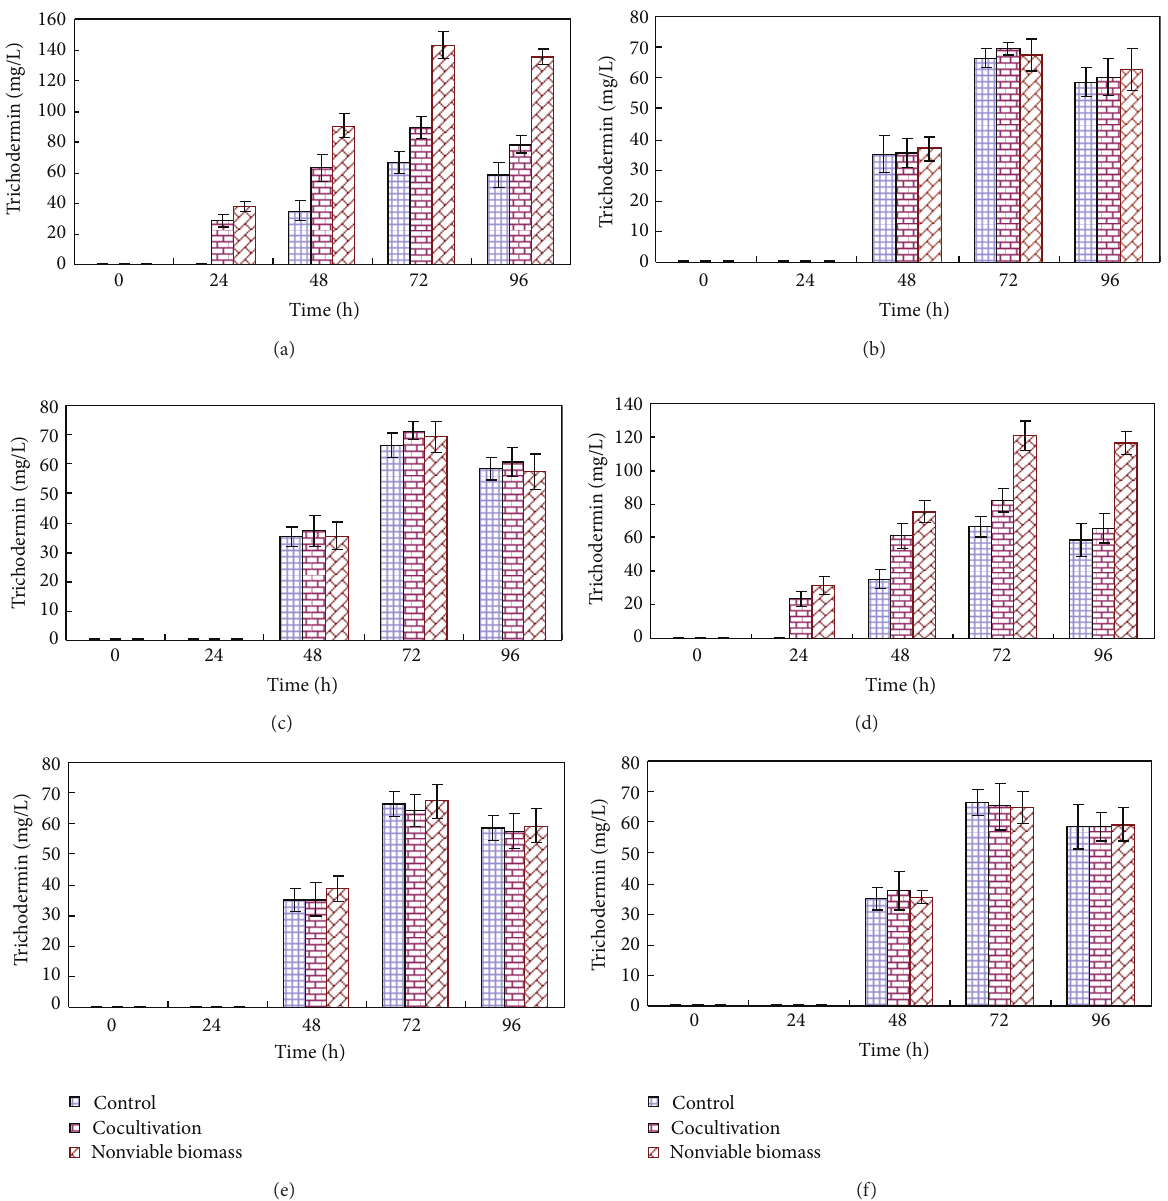
Figure 1: Trichodermin production by T. brevicompactum at the presence of pathogenic fungi. (a) R. solani , (b) B. cinerea , (c) T. cucumeris , (d) F. oxysporum , (e) A. solani , (f) C. lindemuthianum